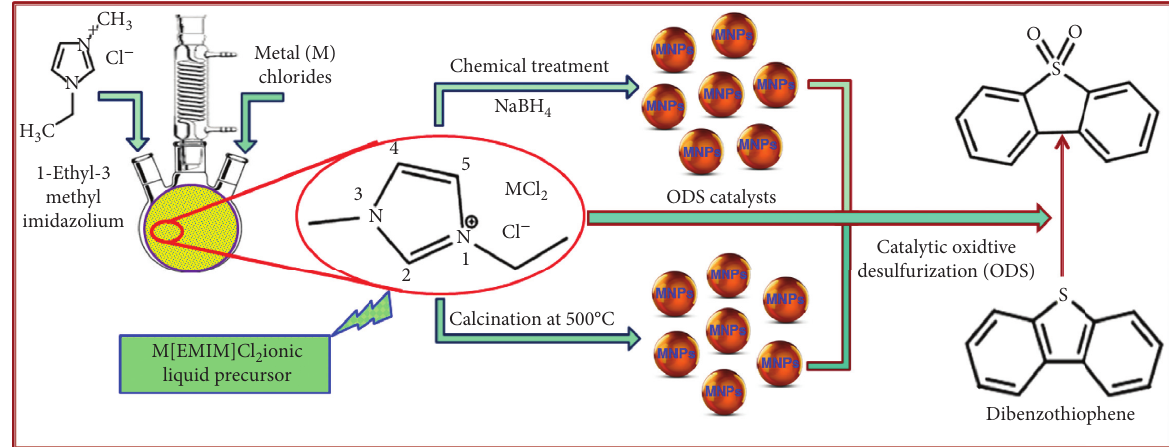
Scheme 1: Schematic representation of the preparation of metal-containing ionic liquid complexes and the preparation of metallic nanoparticles (NPs). Both ionic liquid complexes and NPs were used as catalysts for the catalytic oxidative desulfurization of